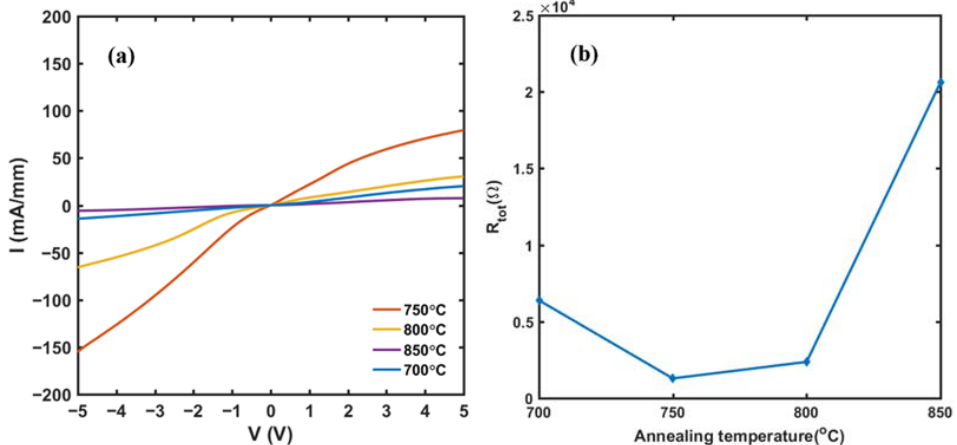
Figure 7. ( a ) I ‐ V characteristics of side ohmic contact TLM electrodes, with a distance of 40 μ m at different annealing temperatures. ( b ) The total resistance of side ohmic contact TLM electrodes with the change of annealing temperature.